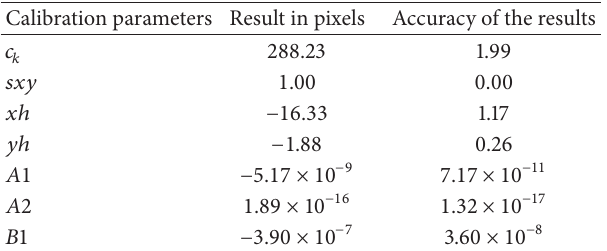
Table 1: Parameters of photo lens optics, camera Canon